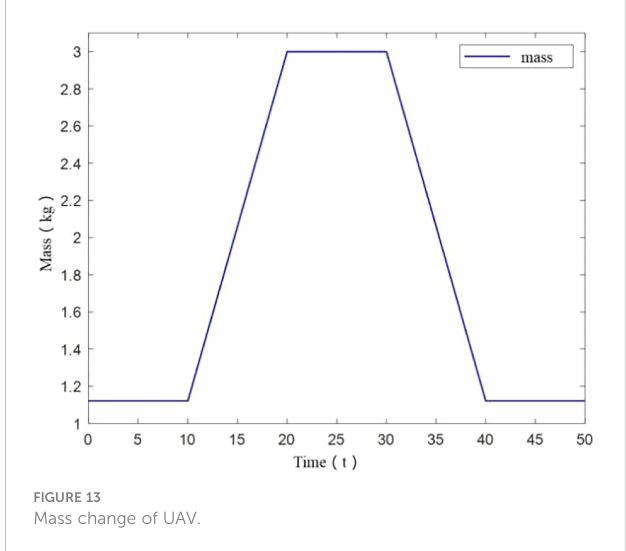
FIGURE 13 Mass change of